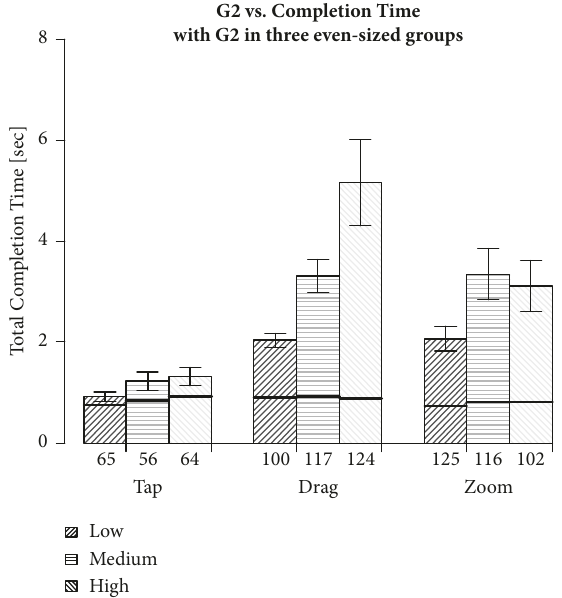
Figure 24: Completion time for the three task types depending on RMS of angular speeds ( ∘ /s) for G1 (roll). The number of samples is provided below the histograms. Horizontal bars denote the average time to first reaction.